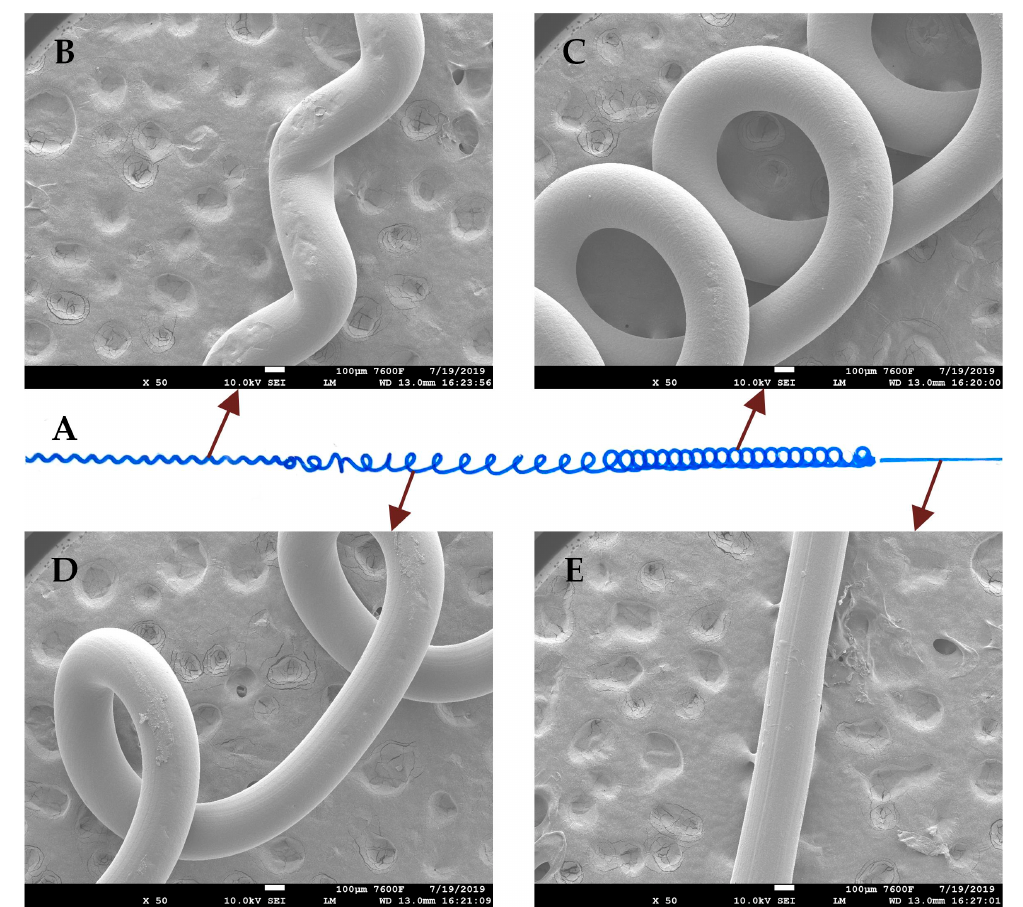
Figure 6. Fabrication of the combined microchannel with di ff erent structural features along straight path. ( A ) Optical photo of the fabricated microchannel. A blue dye solution is perfused into the microchannel for visualization; SEM images of the corresponding channel molds for sinusoidal section ( B ), cross-linked curved section ( C ); 3D curved section ( D ) and straight section ( E